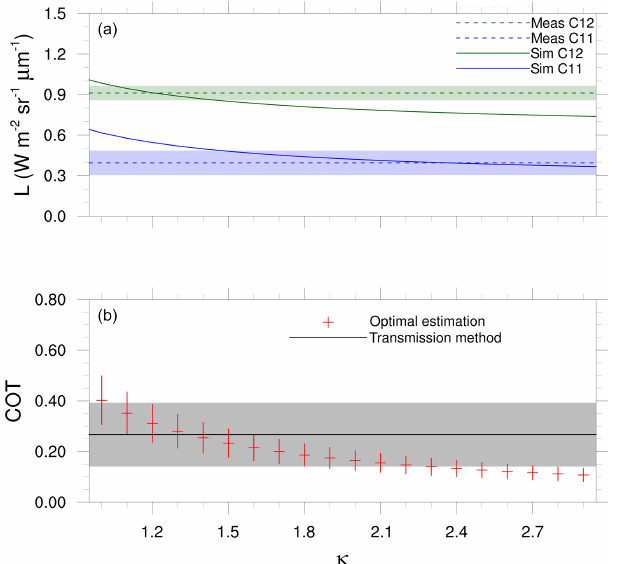
Figure 9. Same as Fig. 8 for the lidar profile measured on 30 November 2016 at